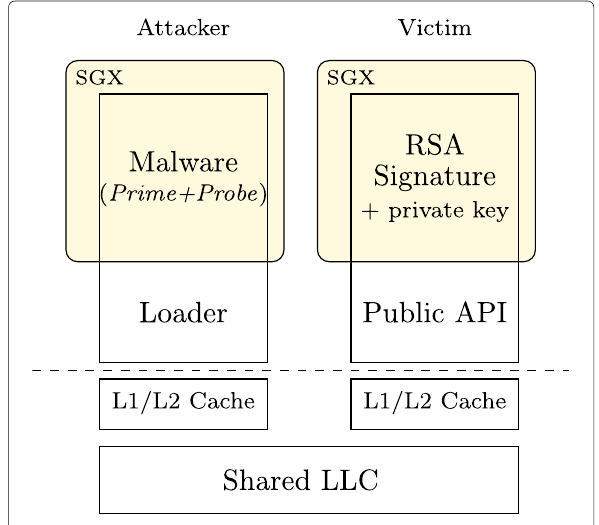
Fig. 2 The threat model: both attacker and victim run on the same physical machine in different SGX enclaves